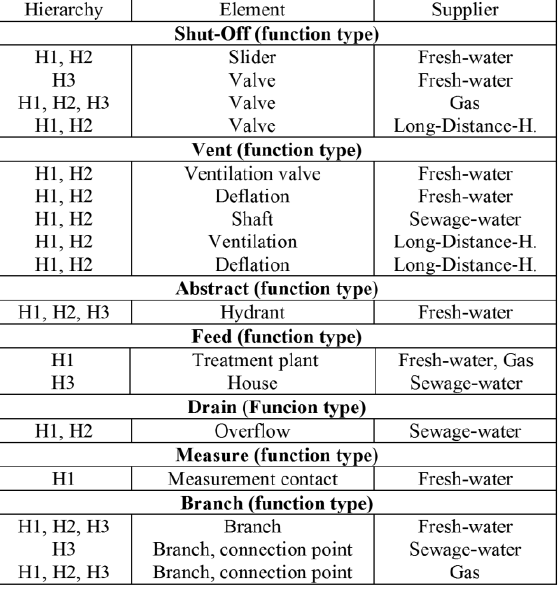
Figure 6. excerpt of functional equivalences across networks and